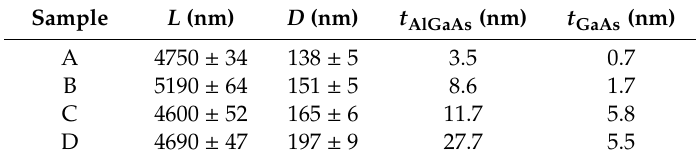
Figure 1. ( a ) Scheme of the NWs from [3]; ( b ) cross-section from [3]; ( c ) SEM image of Sample A (side view). The inset shows the scheme of the gold coating layer. Table 1. Fabrication parameters of the nanowire (NW) samples. Data from